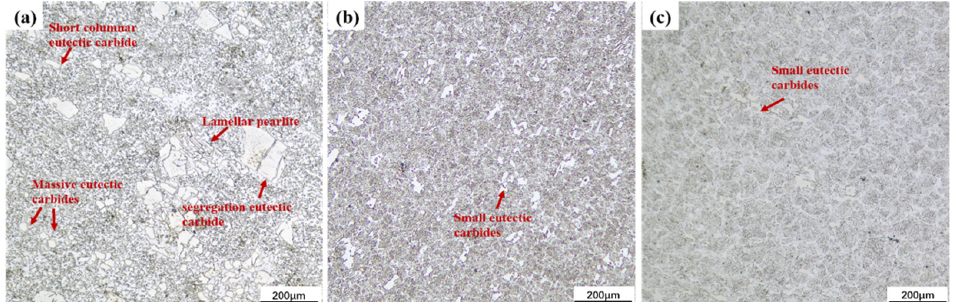
Materials 2022 , 15 , x FOR PEER REVIEW Figure 3. Microstructure of the specimen. ( a ) UT; ( b ) LQ; ( c ) LQ-LSP. Figure 3. Microstructure of the specimen. ( a ) UT; ( b ) LQ; ( c ) LQ-LSP.